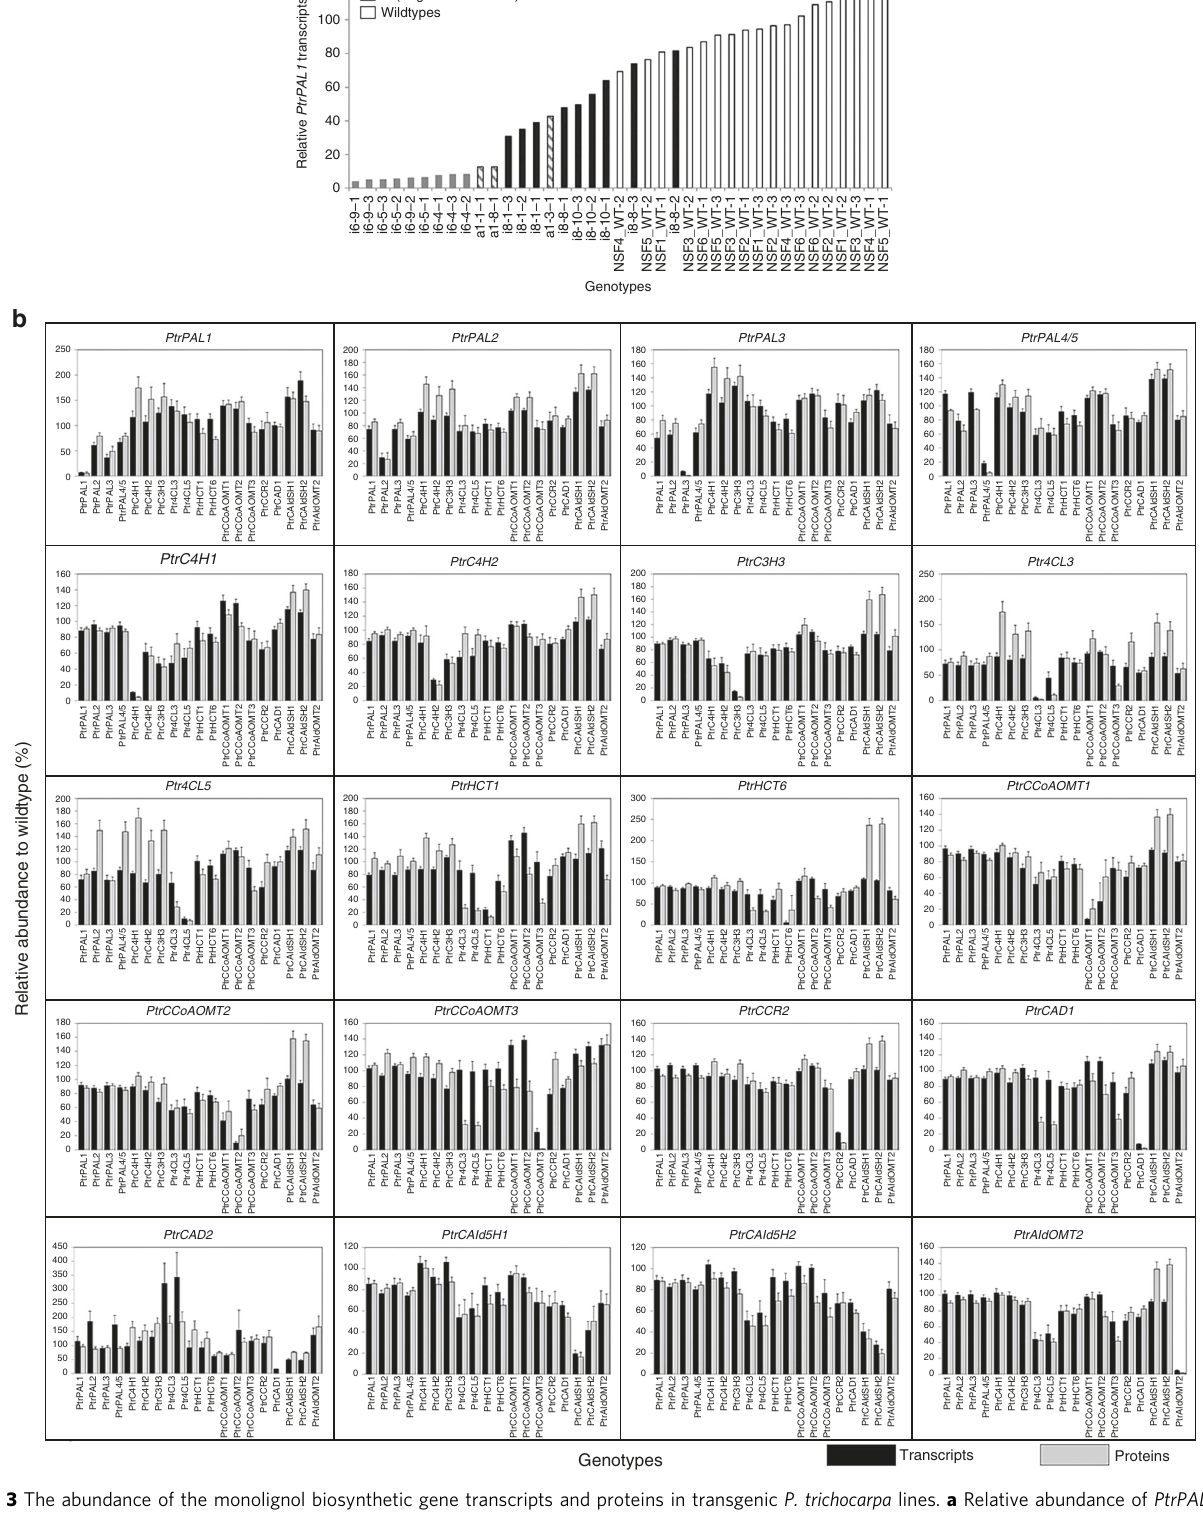
Fig. 3 The abundance of the monolignol biosynthetic gene transcripts and proteins in transgenic P. trichocarpa lines. a Relative abundance of PtrPAL1 transcripts in the transgenic and wildtype P. trichocarpa . White bars represent PtrPAL1 transcript abundance in wildtype trees. Striped bars represent PtrPAL1 transcript abundance in transgenic lines targeting the downregulation of PtrPAL1 . Gray bars represent PtrPAL1 transcript abundance in transgenic lines targeting the downregulation of both PtrPAL1 and PtrPAL3 . Black bars represent PtrPAL1 transcript abundance in transgenic lines targeting the downregulation of all fi ve PtrPAL s. b The x -axis represents the genotypes of the transgenic lines, and the y -axis represents relative transcript (black bars) and protein (gray bars) abundance to the average wildtype level. Error bars represent the standard error of at least three biological